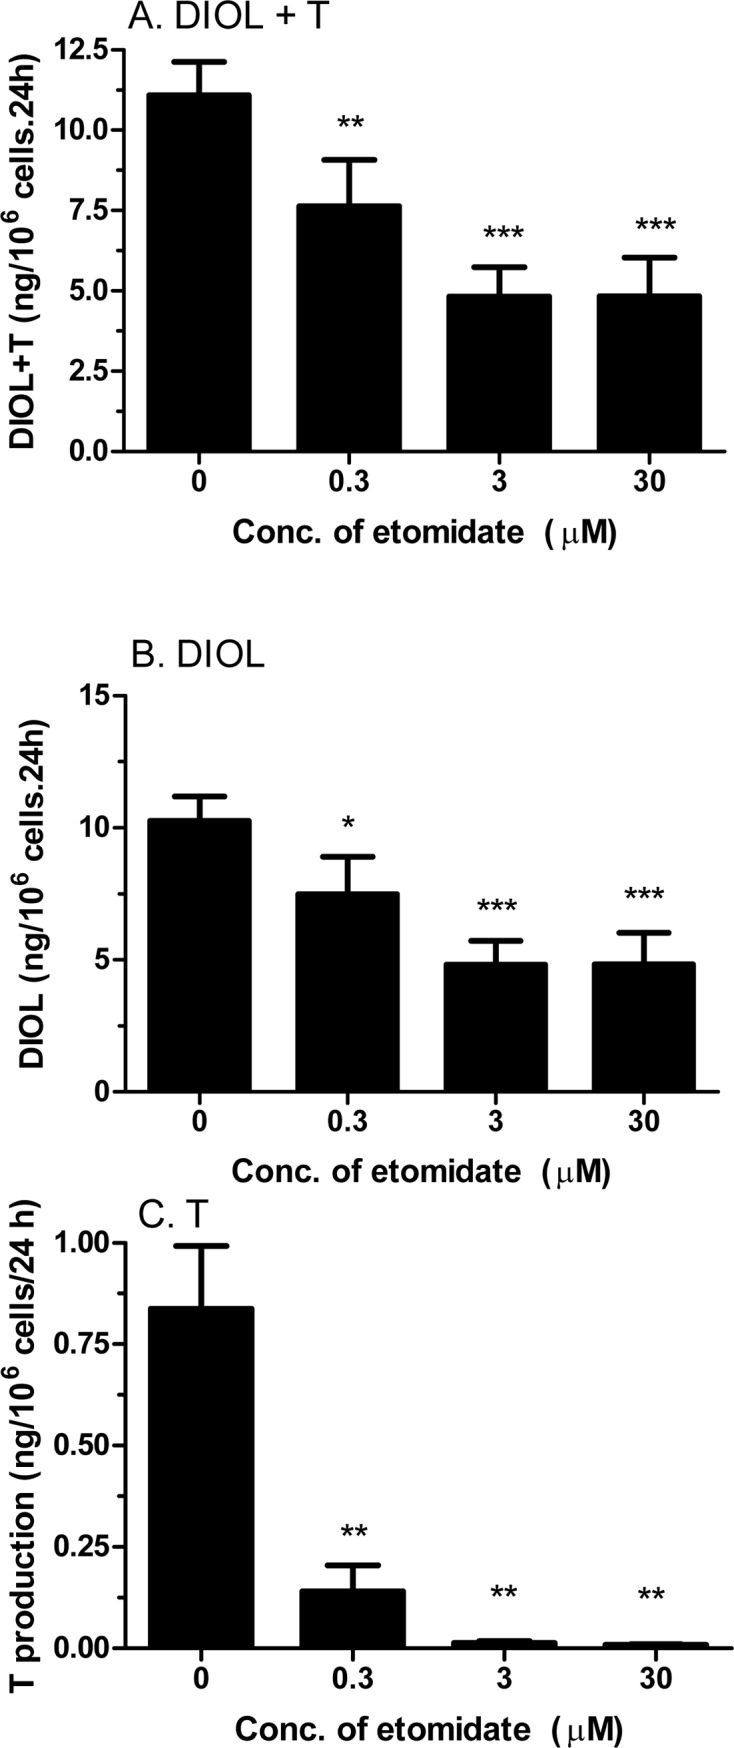
Concentration dependent effects of etomidate on basal androgen production by rat immature Leydig cells.Rat immature Leydig cells were cultured with 0.3–30 μM etomidate (ETO) for 3 hrs. Medium testosterone (T) levels were measured. Mean ± SEM, n = 4; *, **, *** indicate significant difference when compared to control at P < 0.05, 0.01, 0.001, respectively.